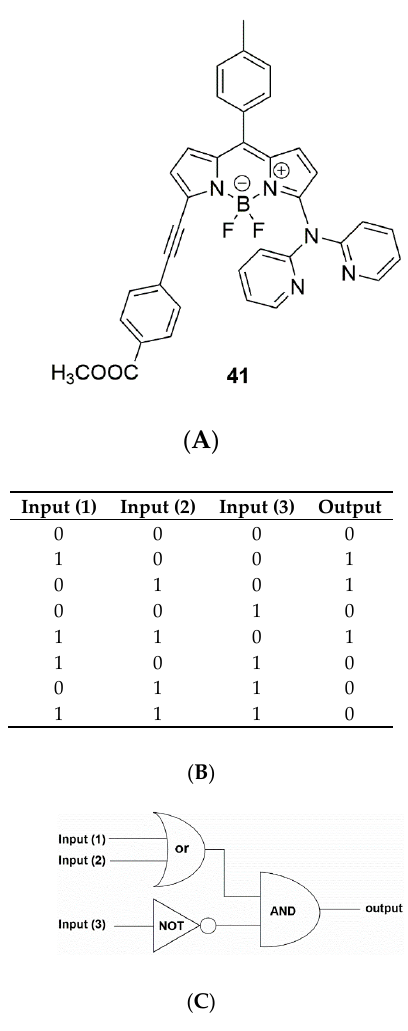
Figure 16. Truth table and logic circuit input (1), (2), and (3) Pb 2+ , Hg 2+ , and Cu 2+ ions (20 μ M, CH 3 CN), respectively, and output is the fluorescence intensity at 587 nm [210]. ( A ) molecular probe, (B) truth table and (C) circuit. ( B ) truth table and ( C )